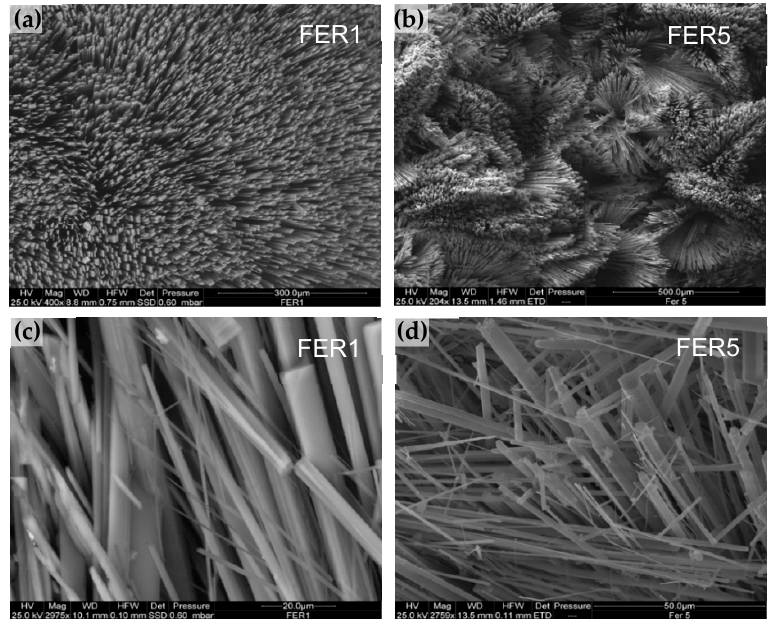
Figure 1. SEM images of the investigated ferrierite samples. ( a , b ) General views of the FER1 and FER5 samples, respectively, with the ferrierite crystals, completely covering the surface of the cavities; ( c , d ) details of the FER1 and FER5 crystals, respectively, with flattened and very elongated prismatic morphologies to fibrous habit; note the highly fibrous character of some ferrierite crystals.